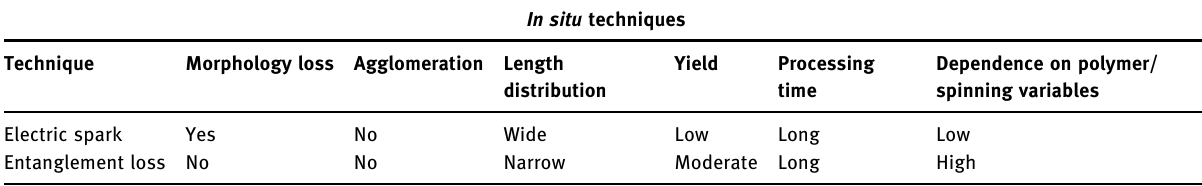
In situ techniques